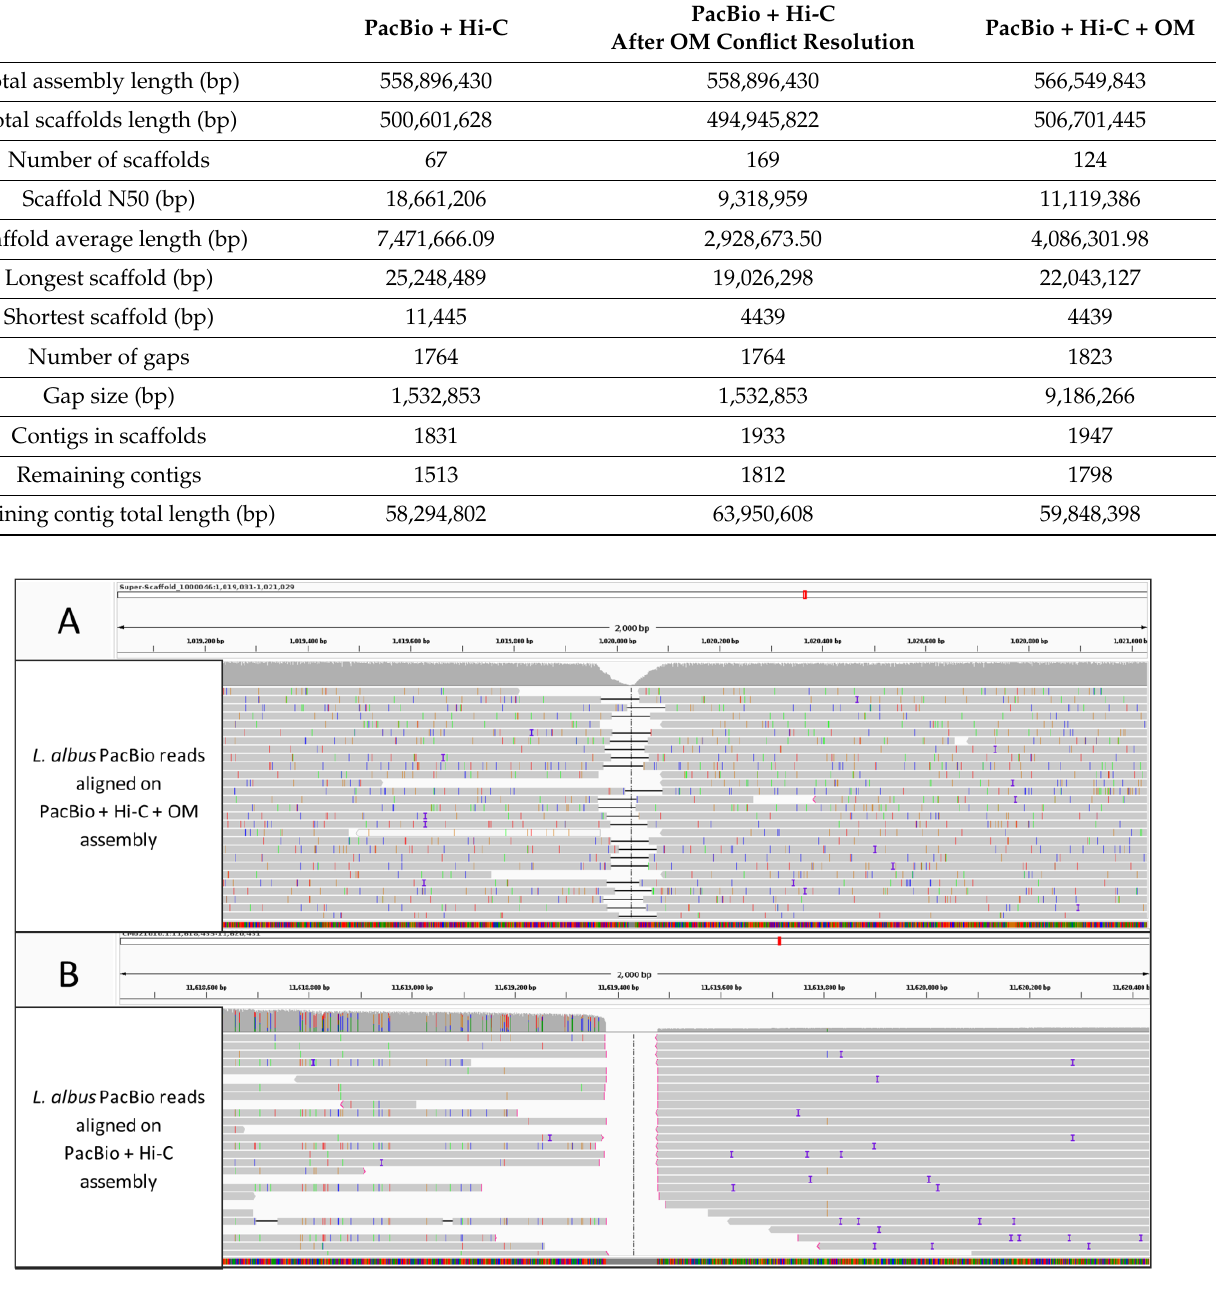
Figure 3. Integrative Genome Browser, visualisation of long PacBio, reads aligned on an OM/Hi- C conflict identified on the L. albus genome